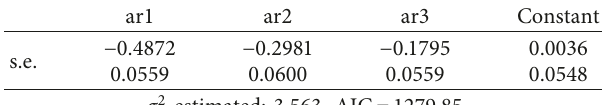
Table 2: Coefficients of the ARIMA(3,1,0)